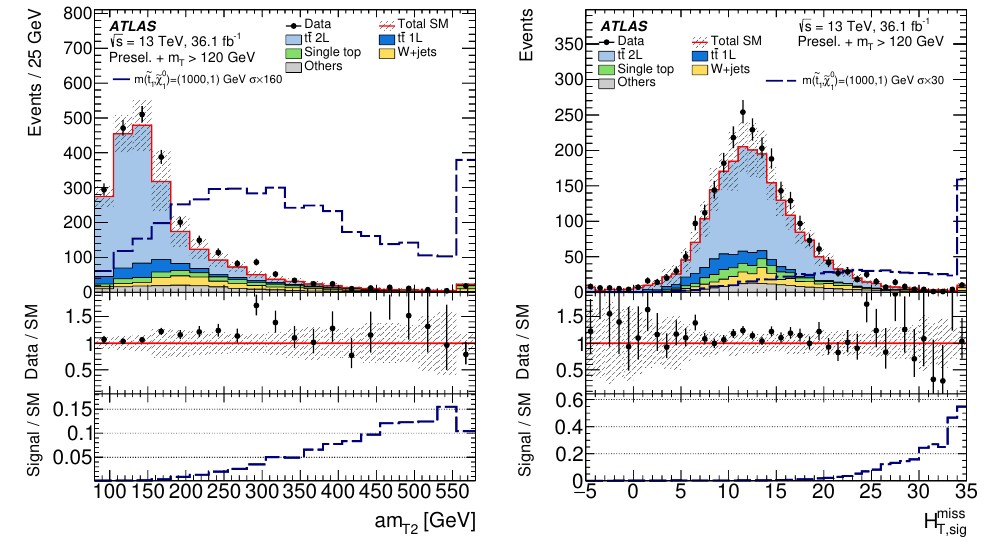
Figure 5 . Distributions of discriminating variables: (left) am T2 and (right) H miss E miss